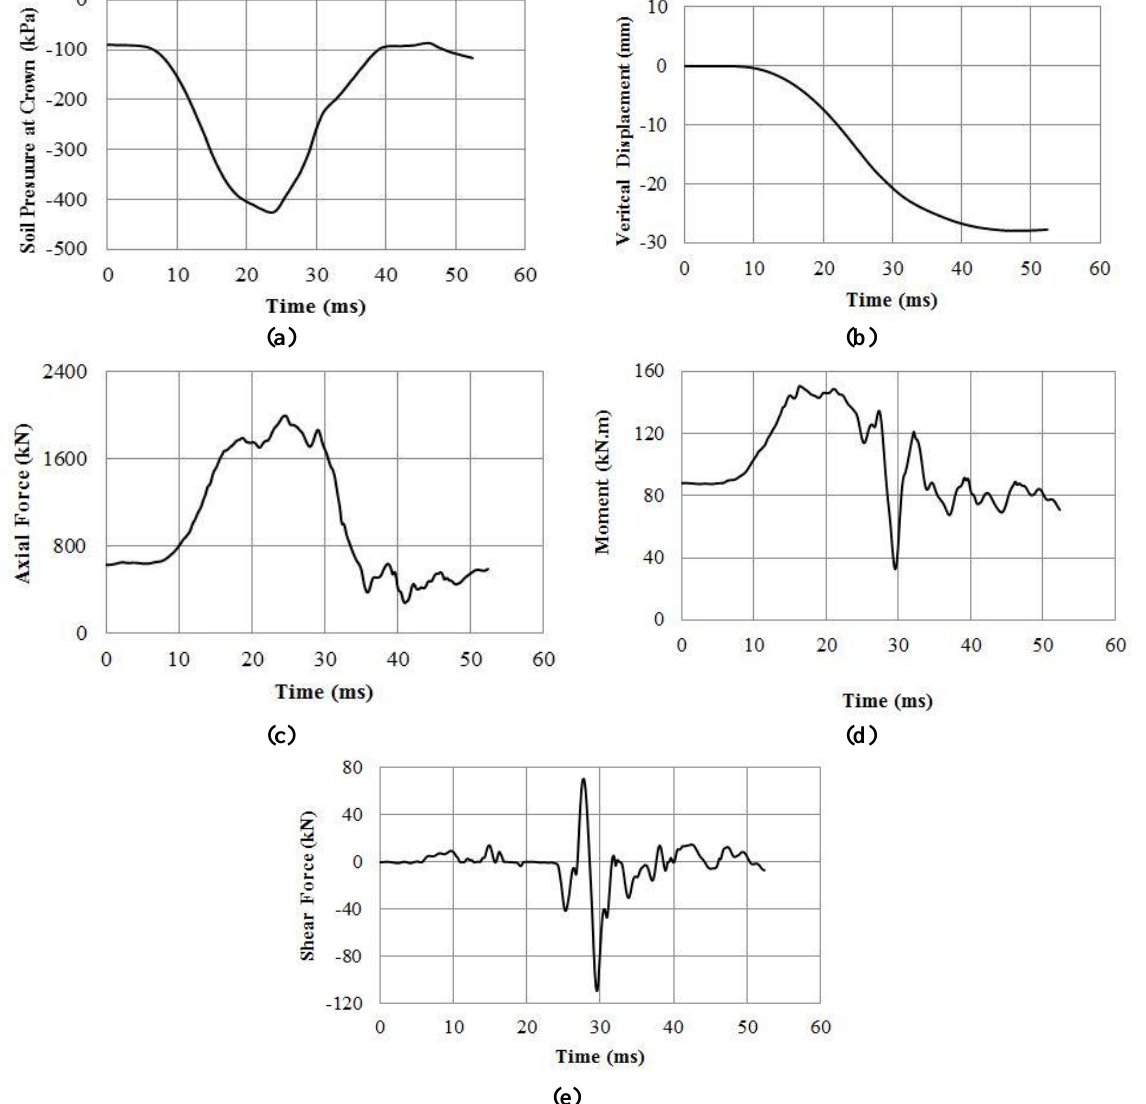
Fig. 5. Time history responses of different soil and lining parameters at tunnel crown in analysis No. 5:(a) soil pressure at crown; (b) vertical displacement; (c) axial force; (d) moment; (e) shear